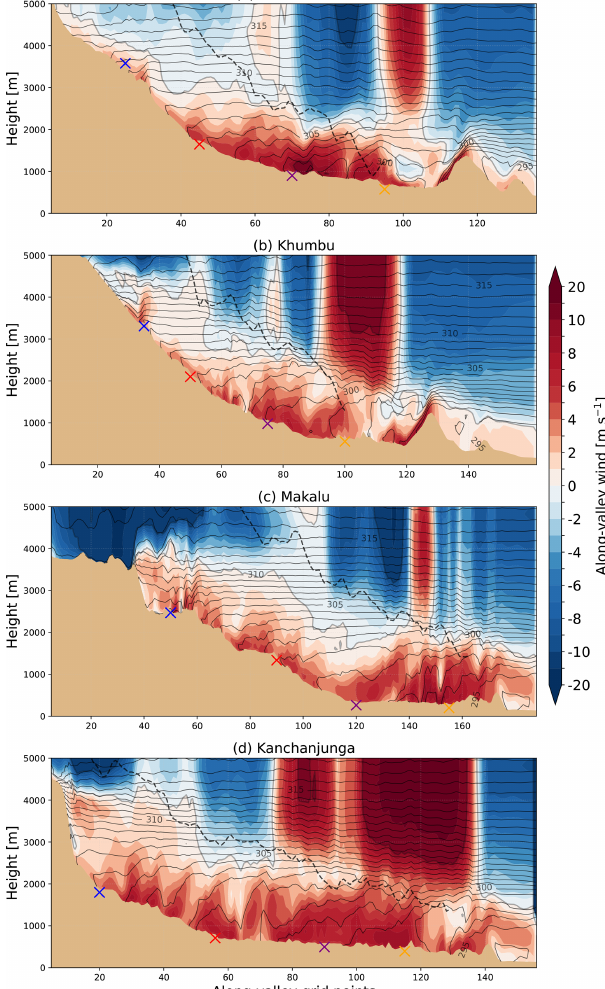
Figure 8. Vertical cross-section of potential temperature (grey con- tours) and the along-valley wind component (shading) above the valley centre lines (yellow lines in Fig. 2) on 20 December at 09:00LT. Potential temperature is plotted with a contour interval of 1K. Positive values for the along-valley wind refer to up-valley winds. The mean of the two ridge heights is shown by the black dashed lines.